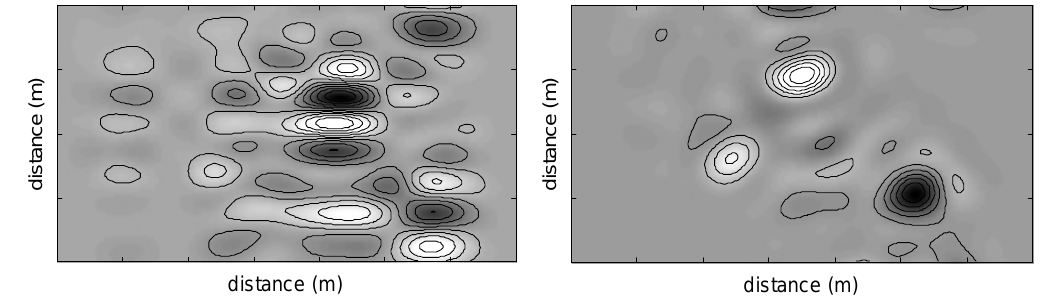
Fig. 6. Divergence of the structural intensity for a plate with free-free boundary conditions obtained by processing the measured vibrating normal velocity in wavenumber domain using respectively direct SFT (left) and the mirror method (right) before the Fourier transform is performed. The divergence is represented by gray scales. The representation dynamic is 20 dB.